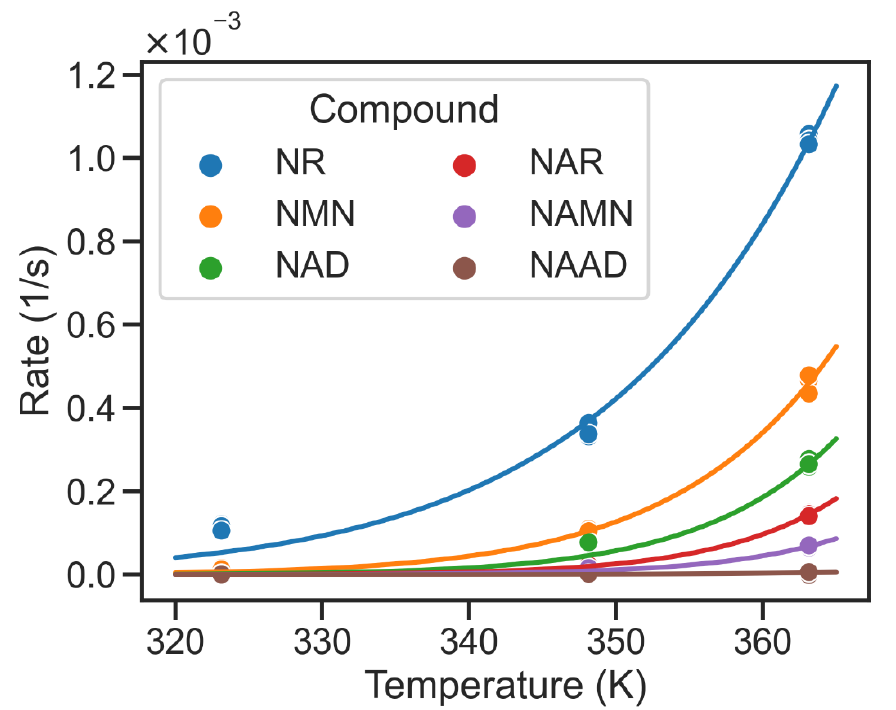
Figure 3. Temperature dependency of non-enzymatic hydrolysis of metabolic intermediates of NAD biosynthesis. Temperature on x-axis is reported in Kelvin (K). Hydrolysis rates are given per second (1/s). While the solid dots represent measured hydrolysis rates, the solid lines denote the temperature- dependent hydrolysis rates calculated using a fitted Arrhenius equation (cf. Table 1). NAAD shows the lowest hydrolysis rates, while NR exhibits the highest glycohydrolysis rate at 363.15